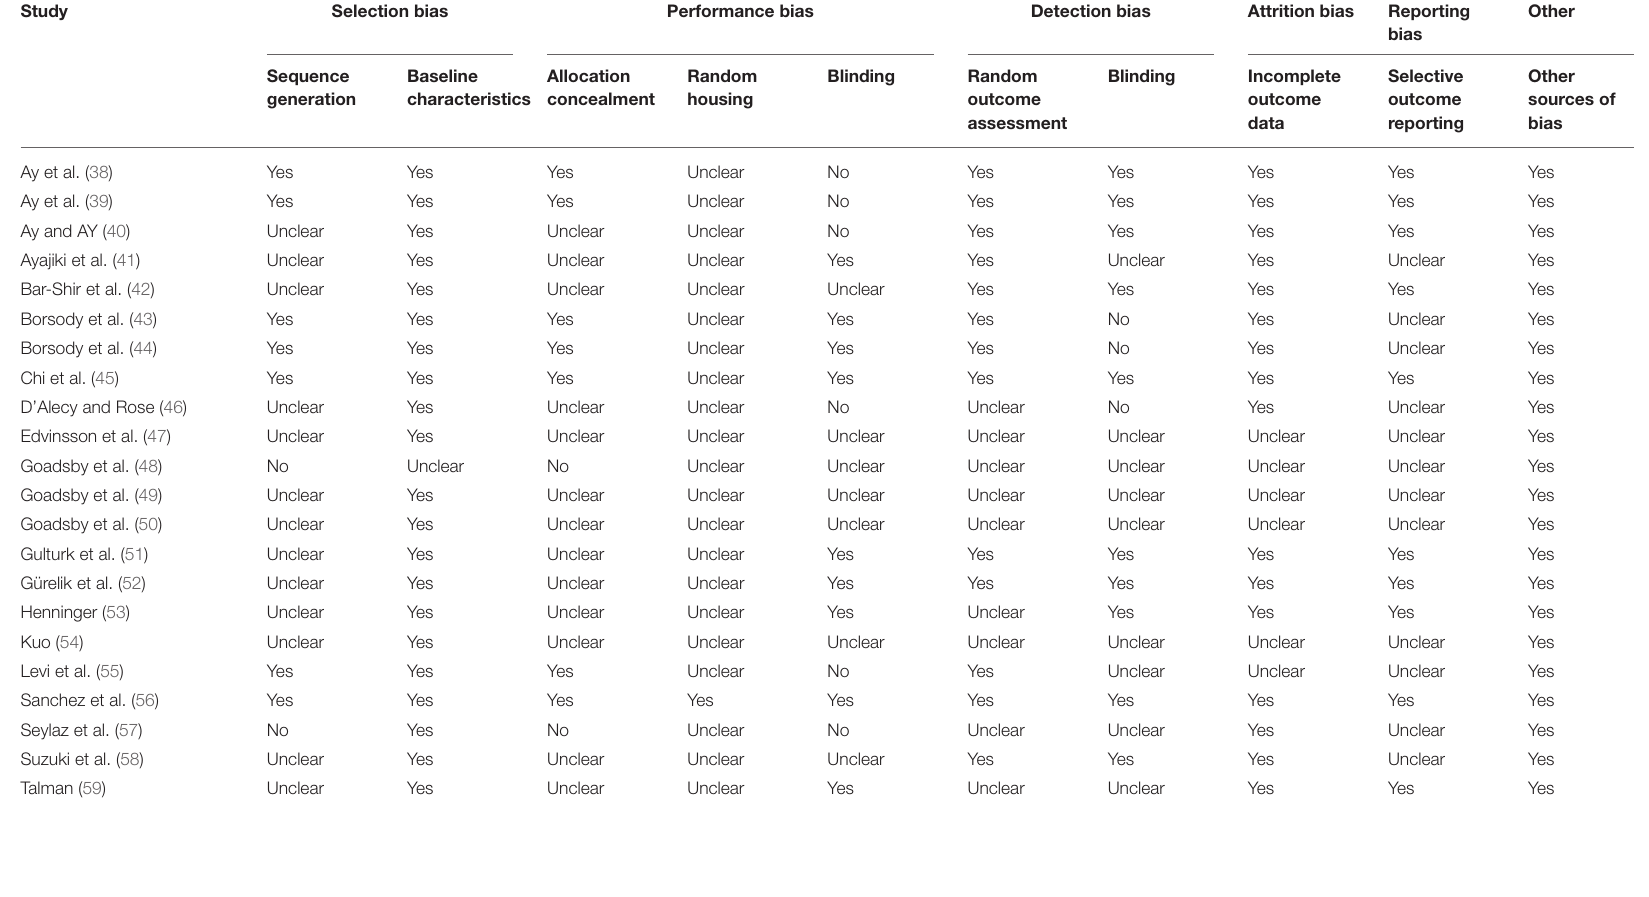
TABLE 1 | Quality assessment of included pre-clinical studies using SYRCLE’s